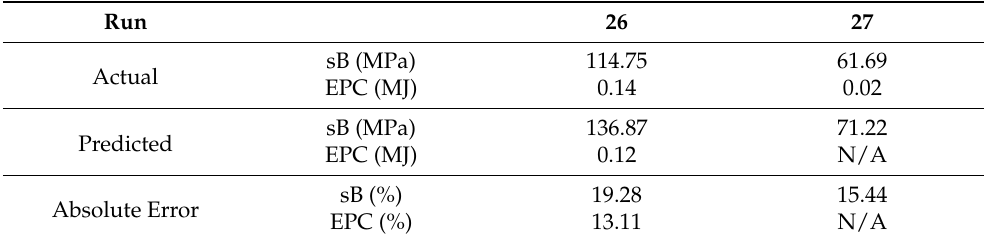
Table 11. Validation